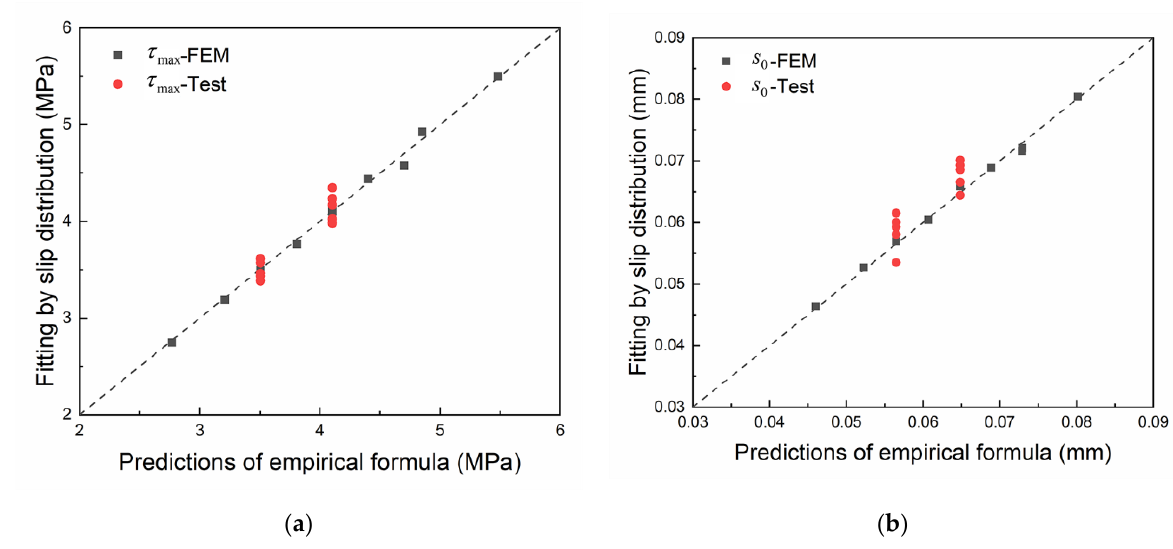
Figure 23. Verification of empirical formulas: ( a ) the maximum bond stress; ( b ) the slip at the maximum bond stress.